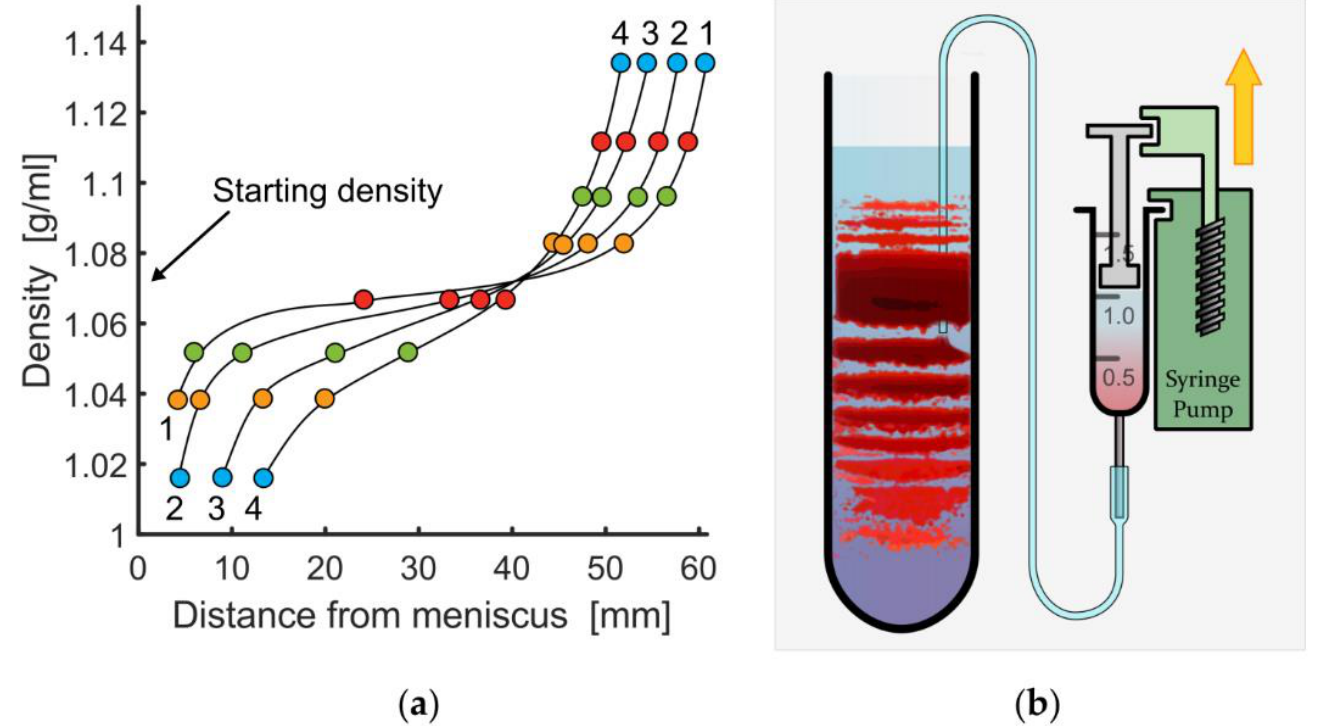
Figure 1. ( a ) Density gradient measurements of Percoll medium by GE Healthcare using colored beads in an angle head rotor at 20,000 × g and varying centrifugation duration, (1) 15 min, (2) 30 min, (3) 60 min, (4) 90 min, reproduced from [5]; ( b ) scheme of the cell-extraction process of from a single band using micro medical tubing and a syringe pump.